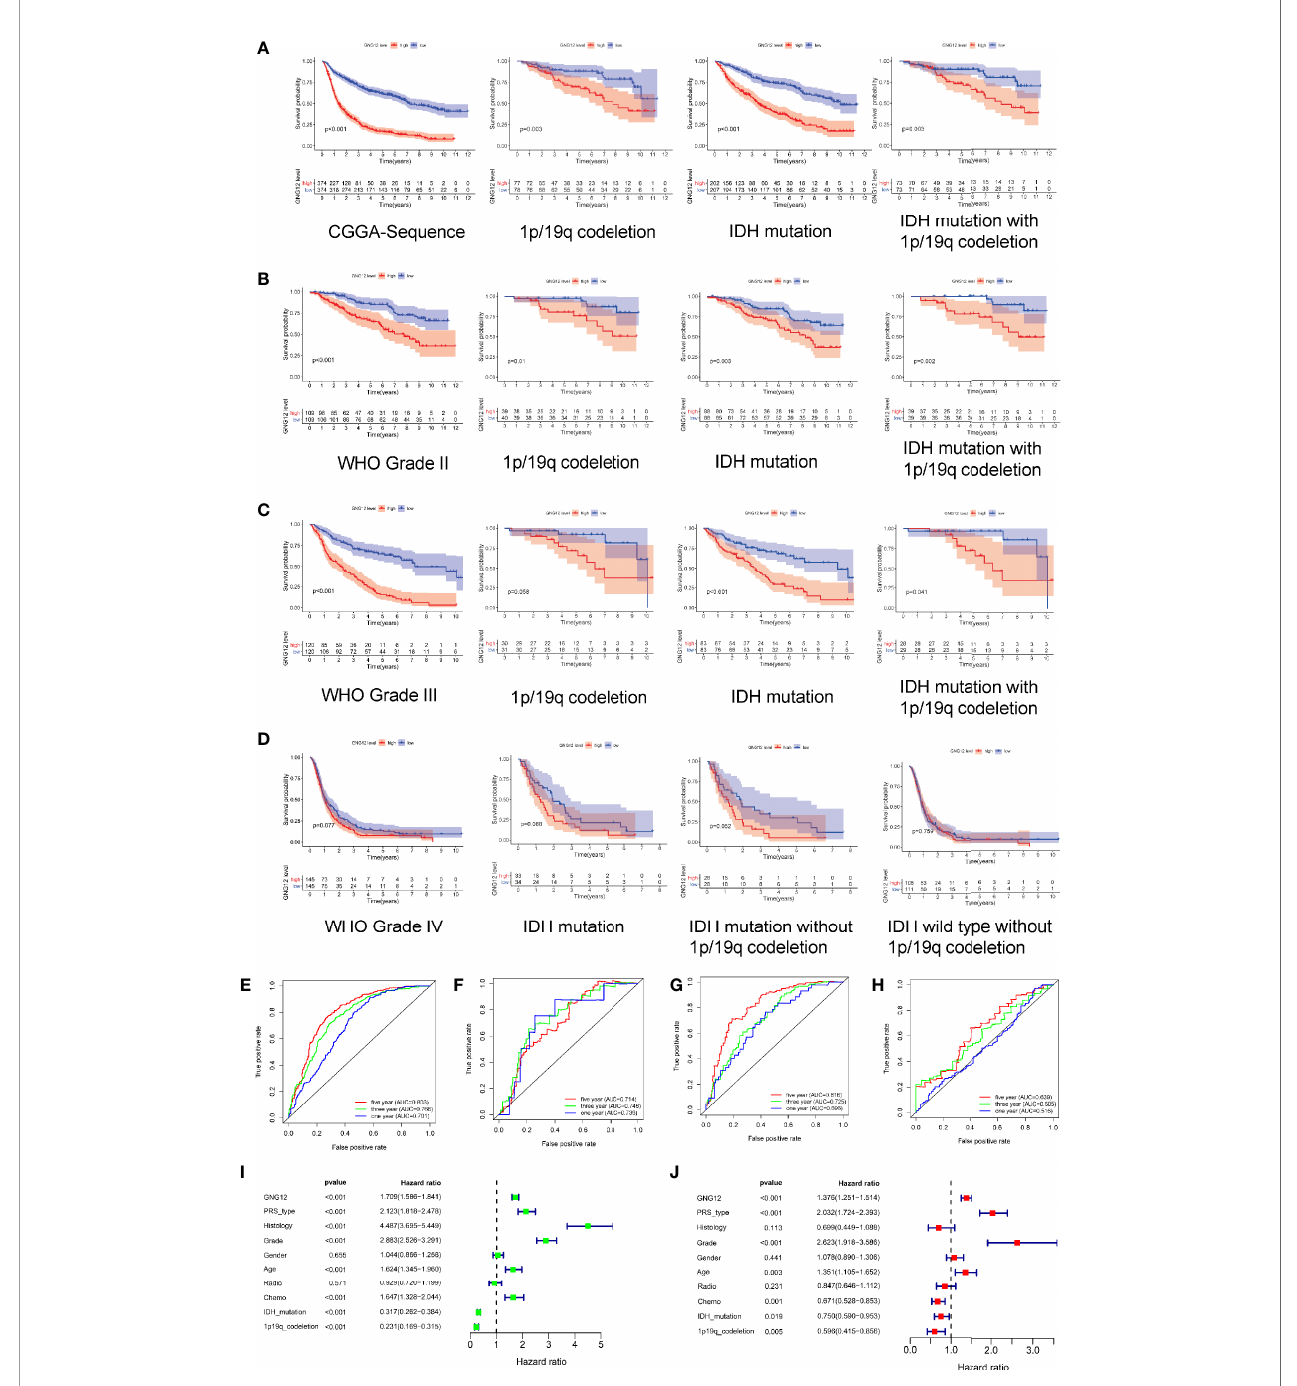
FIGURE 3 | Relationship between different expression status of GNG12 and prognosis of glioma patients based on CGGA RNA-seq data. (A) In order, overall survival based on CGGA database, survival with 1p/19q co-deletion, survival with IDH mutation and survival with IDH mutation with 1p/19q co-deletion. (B) Survival rates for WHO grade 2, survival with 1p/19q co-deletion in grade 2, survival with IDH mutation and survival with IDH mutation with 1p/19q co-deletion, in that order. (C) In order, the survival rate of WHO grade 3, the survival rate of 1p/19q co-deletion in grade 3, the survival rate of IDH mutation and the survival rate of IDH mutation with 1p/19q co-deletion. (D) In order, the survival rate of WHO grade 4, the survival rate of IDH mutation in grade 4, the survival rate of IDH mutation without 1p/19q co-deletion and the survival rate of IDH wild type without 1p/19q co-deletion. (E – H) ROC curve shows that GNG12 has good diagnostic value in glioma, ROC curves of overall glioma based on CGGA and different WHO classi fi cations. (I, J) Analysis of univariate and multivariate factors affecting the prognosis of patients with glioma. (I) Univariate regression analysis; (J) Multivariate